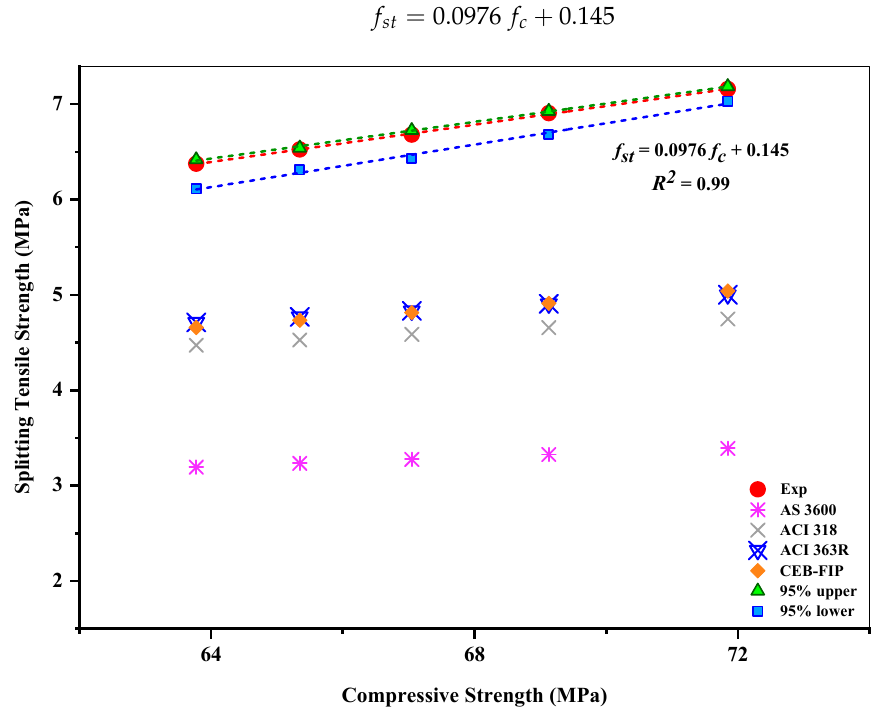
Figure 17. Relationship between the compressive and splitting tensile strengths of RHA-incorporated concrete mixes.